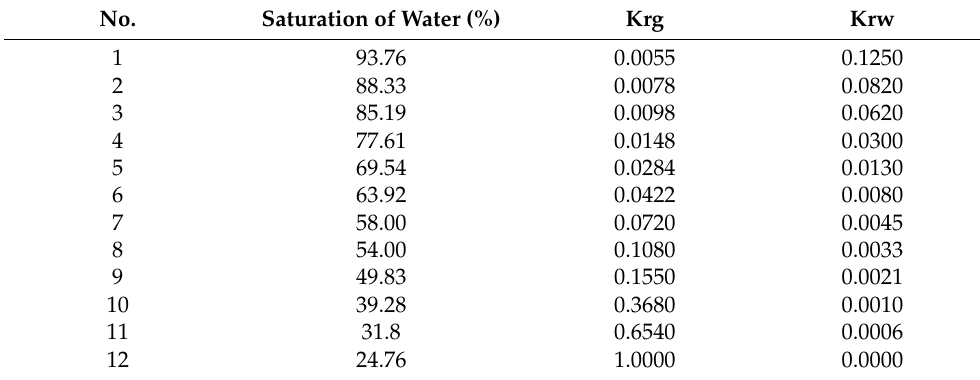
Table A7. The relative permeabilities of No.3 sandstone sample.